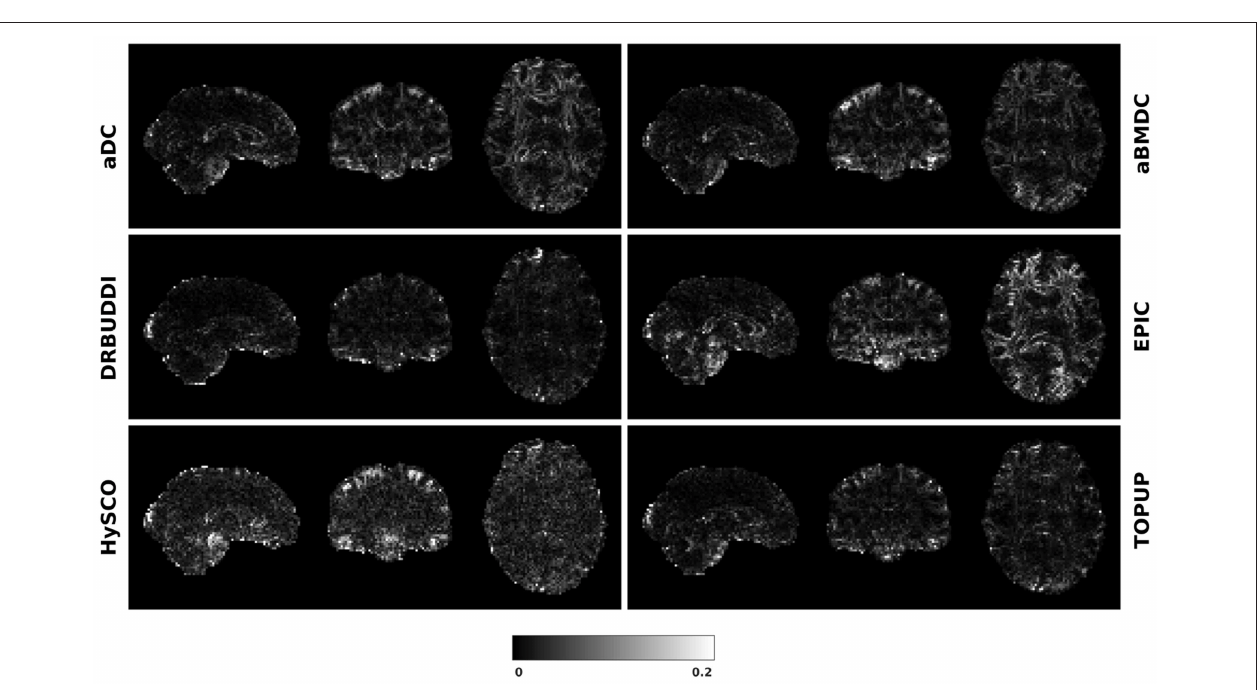
FIGURE 12 | FA standard deviation over the corrected LR, RL, AP, and PA data for simulated HCP Subject 100206 using the six methods.